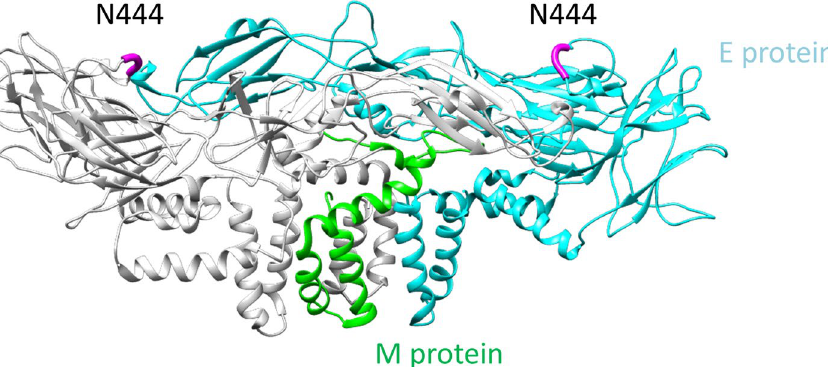
Figure 3. Exemplary illustrated structure of the M/E protein of ZIKV. The structure of the heterodimer protein M and E complex (PDB: 5h37) is illustrated. This complex is formed from an M protein homodimer (monomer visualized in green) and an E protein homodimer (monomer visualized in cyan). The potential N -glycosylation site N444 is highlighted in magenta.